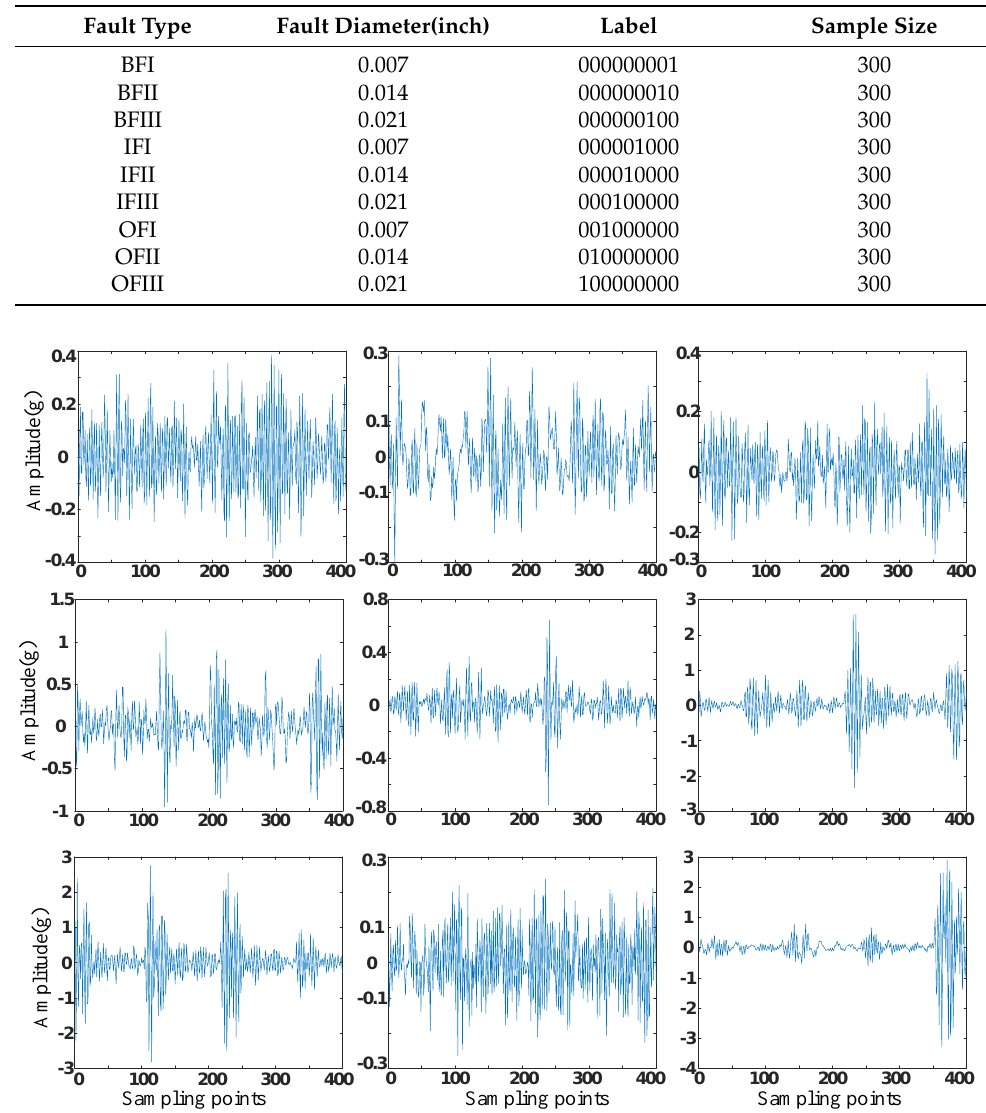
Figure 11. Continuous time signal diagram of 9 kinds of faults.